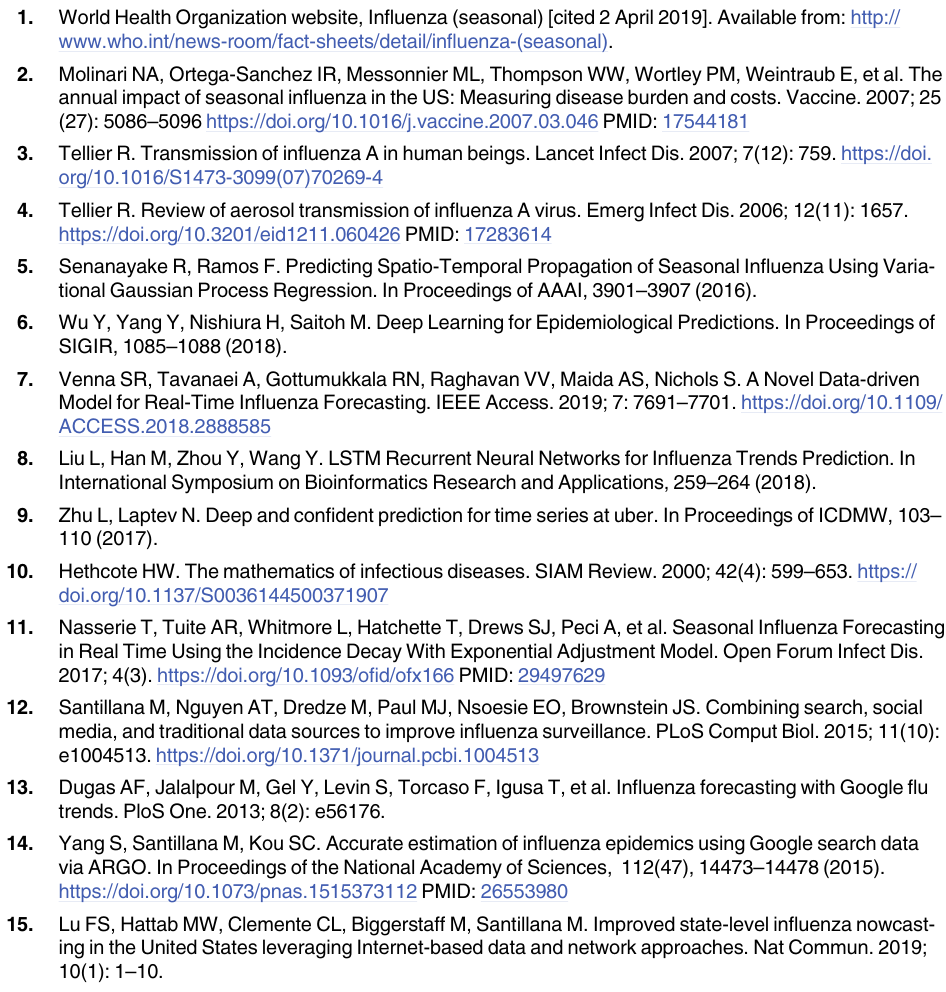
prefecture for the compared models. Each colored box indicates a different model; from left to right: VAR (cyan), LSTM (green), CNNRNN-Res (blue), GCN+S2s w/ AD (pink), GCN+S2s w/ DD (brown), and GCN+S2s w/ PF (red). The black center line in each box indicates the median value; the top and bottom of each box indicate the upper and lower quartiles, respec- tively; the whiskers indicate the maximum and minimum values; and the other points indicate outliers. For visualization, only MAE scores from 0 to 2000 and R 2 scores from -1.0 to 1.0 are